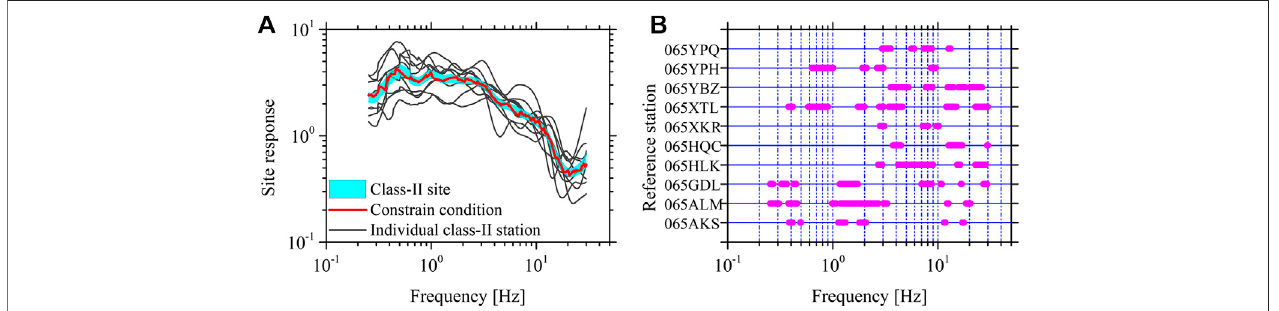
FIGURE 4 | (A) The site responses for 10 class II stations (thin gray lines) were represented by the average of the S-wave horizontal-to-vertical spectral ratios of ground motion recordings with peak ground acceleration not greater than 100 cm/s 2 . A range of the average plus and minus 0.25 SD on the base-10 logarithmic scale over the 10 stations (shaded area) represents the site response of the class II site. At each frequency, stations with site responses falling into the range of the site response of the class II site were selected, and their average site response was used as the constraining condition (thick red line). (B) The selected stations for the constraining condition varied with